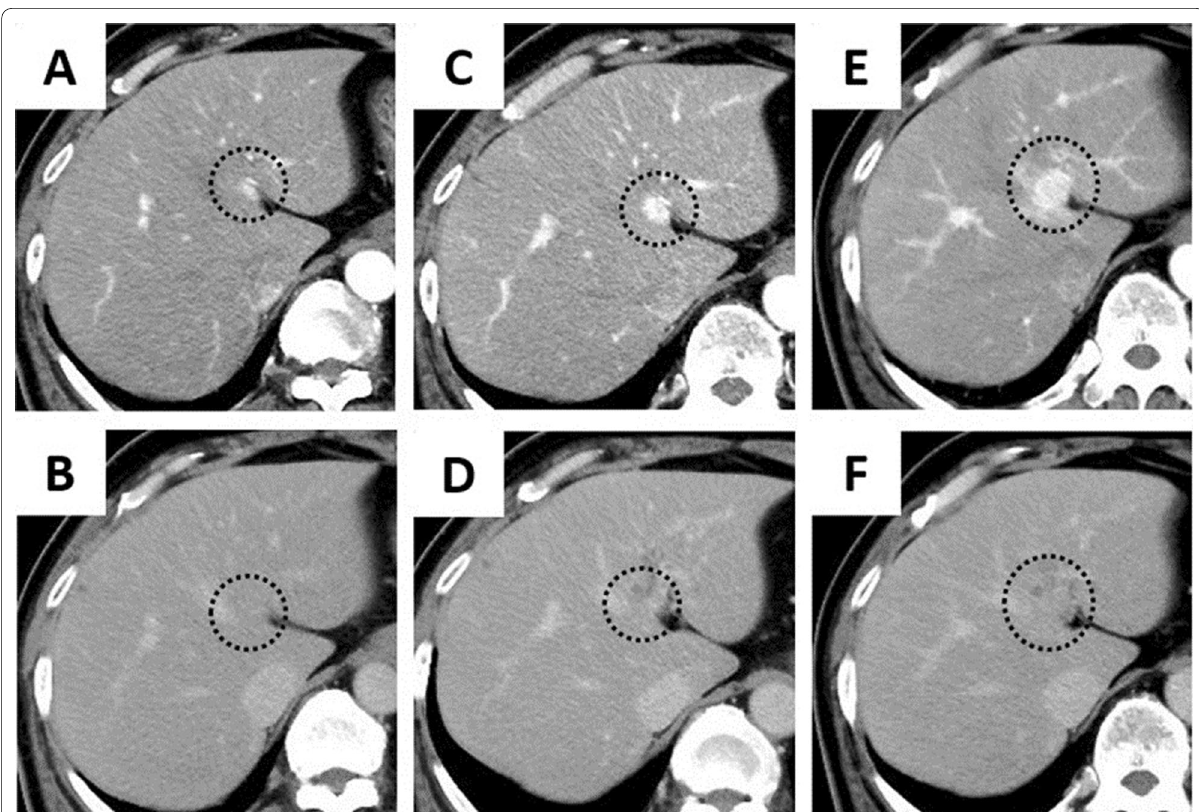
Fig. 1 Dynamic abdominal computed tomography (CT) findings. A In 2015, the arterial phase showed enhancement of tumor at liver segment 4, measuring 10 mm in diameter. B The tumor was isodense during the late phase. C In 2017, the arterial phase showed enhancement of the tumor, measuring 15 mm in diameter. D The tumor remained isodense during the late phase. E In 2020, the arterial phase showed tumor progression, measuring 20 mm in diameter. The tumor was located close to the left first branch of Glisson. F The tumor remained isodense during the late